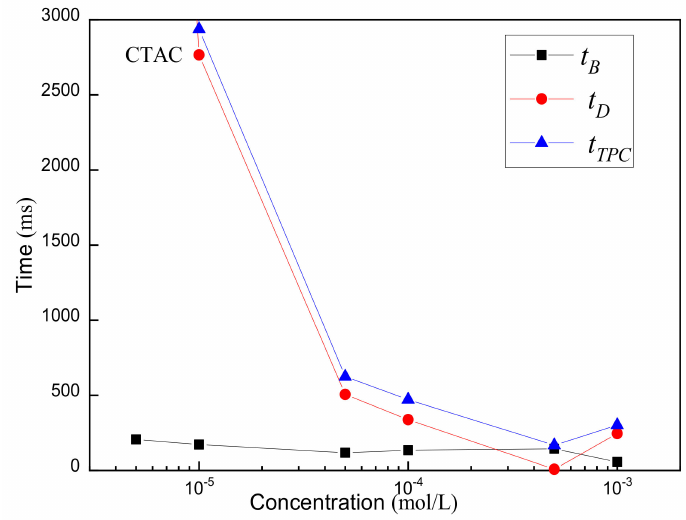
Figure 8. The t TPC , t B , and t D of muscovite in different CTAC concentrations.